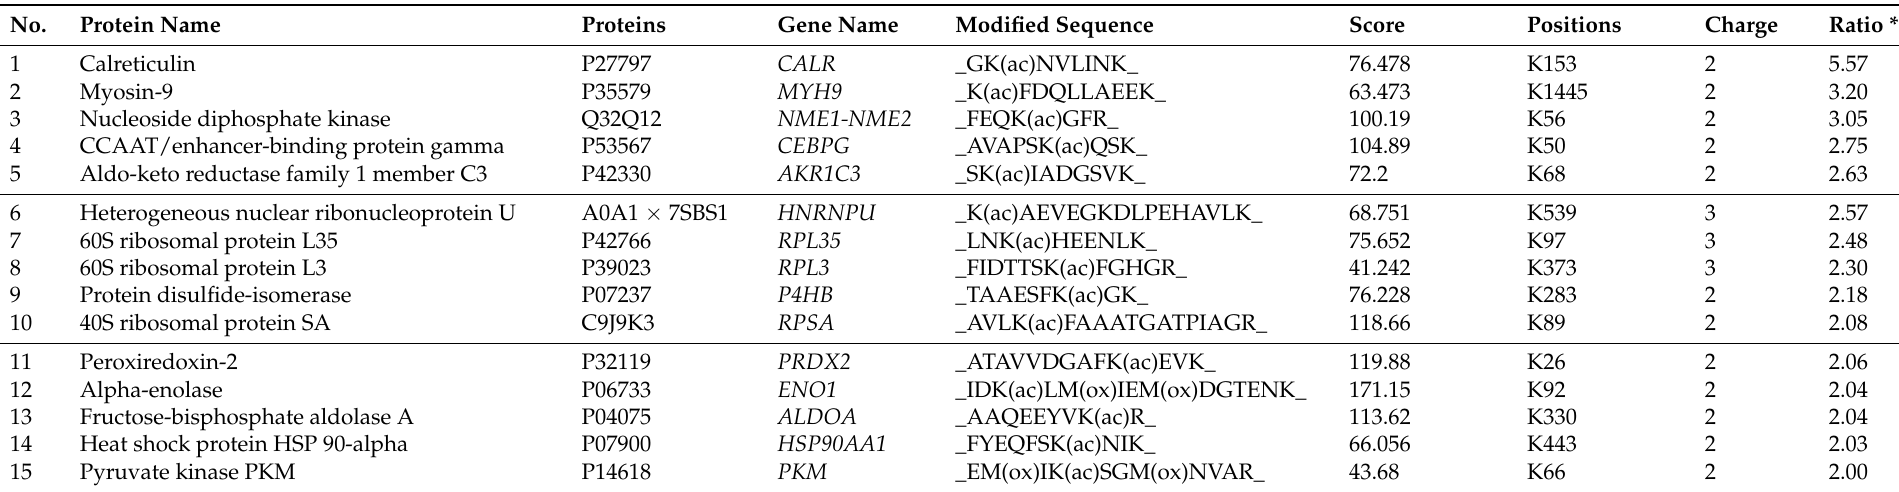
Table 1. The list of upregulated Kac proteins in LPS-induced SILD in HepG2 cells for 24